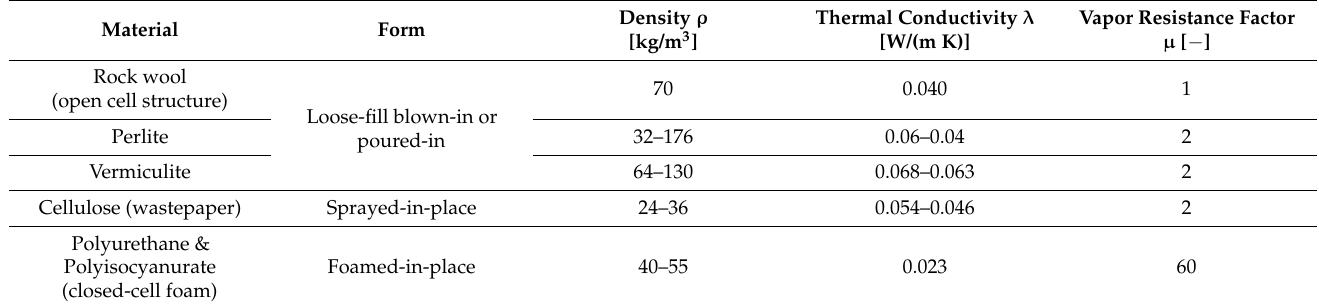
Table 5. Typical filling